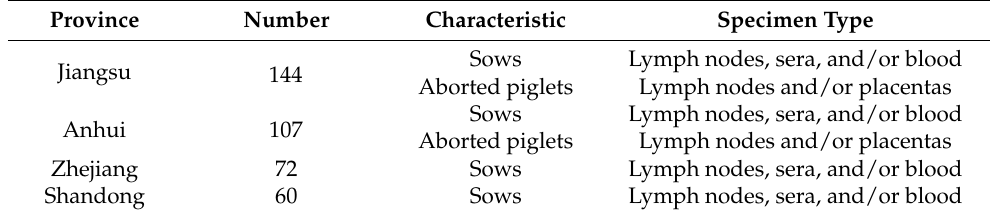
Table 2. The information of field specimens detected in this study.